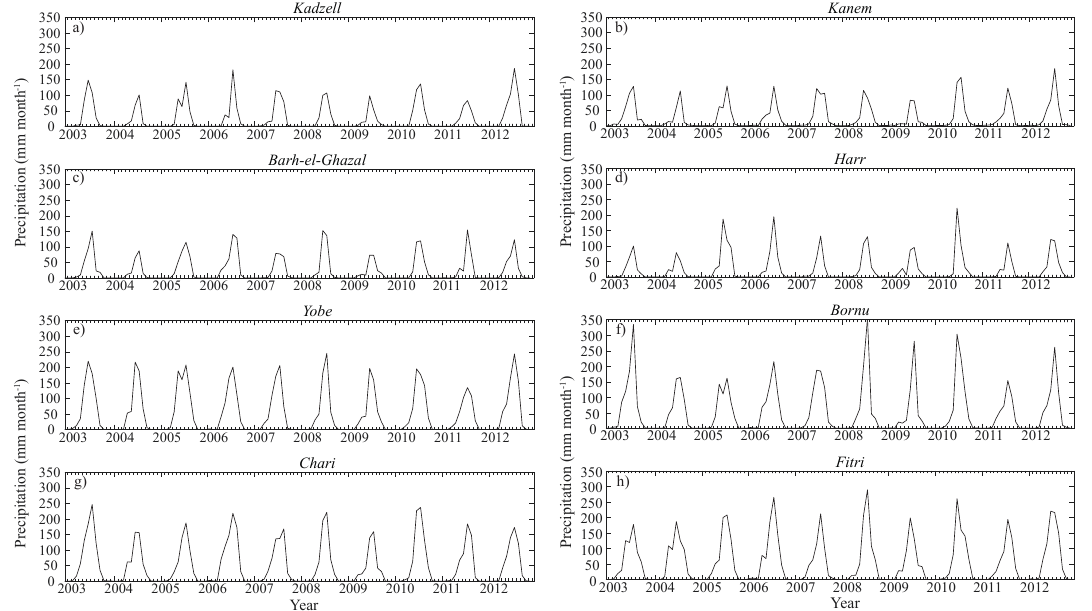
Figure 6. Monthly TRMM-merged product (3B43) for each GRACE tile (see locations in Figure 1). TRMM data were spatially averaged for each GRACE